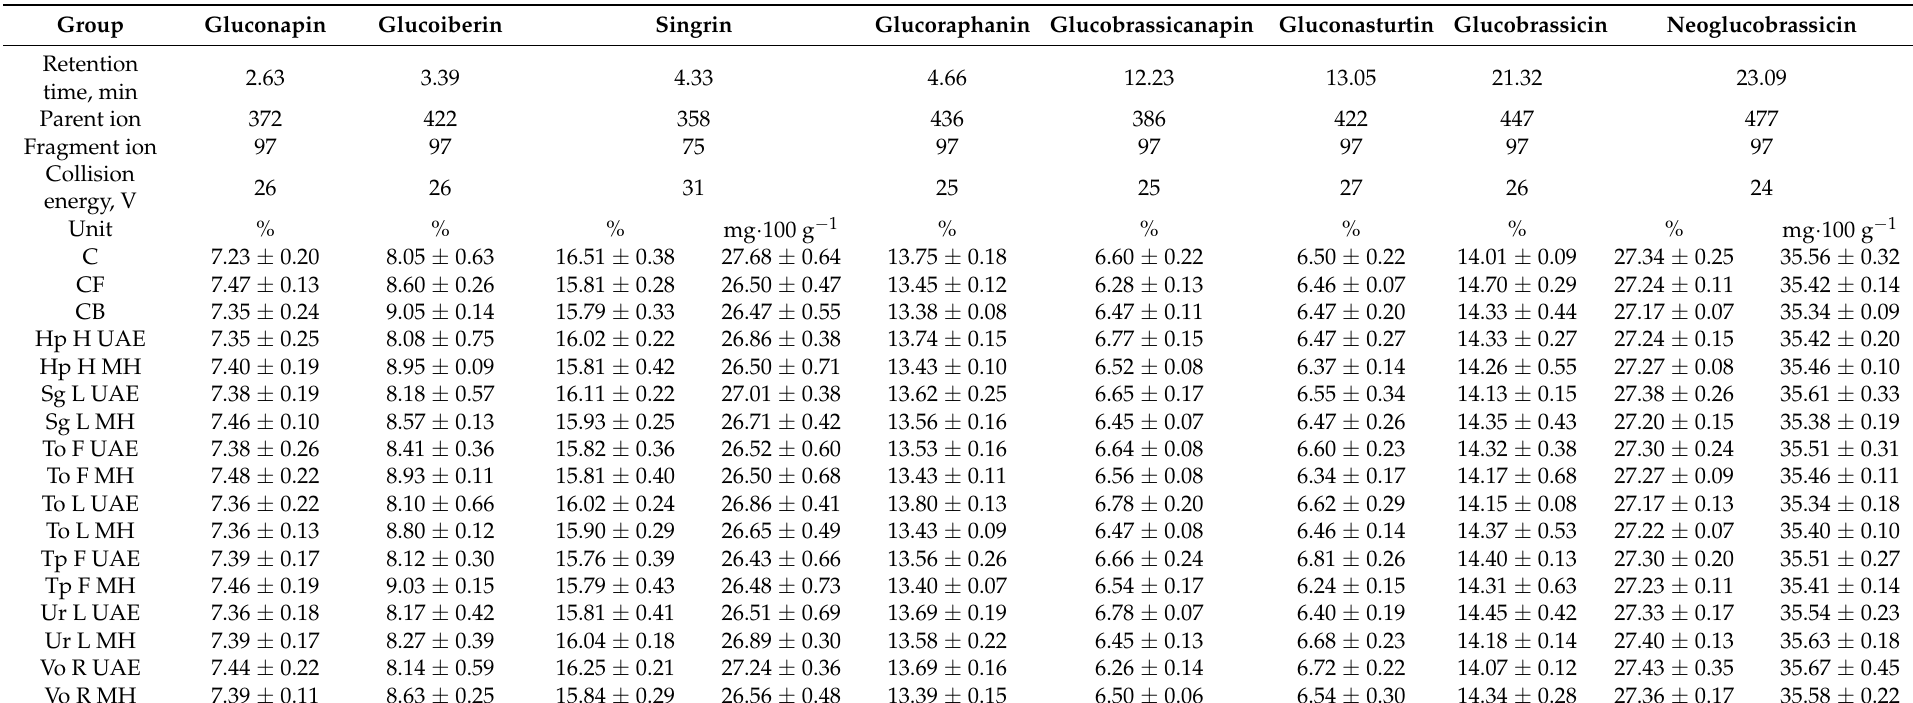
Table 7. Effect of the foliar application of the botanical extracts on the glucosinolates composition (mg · 100 g − 1 and/or the amount of a single component calculated as a percentage (%) of the whole LC-MS chromatogram area) of cabbage head after harvest ( n = 3, mean ±